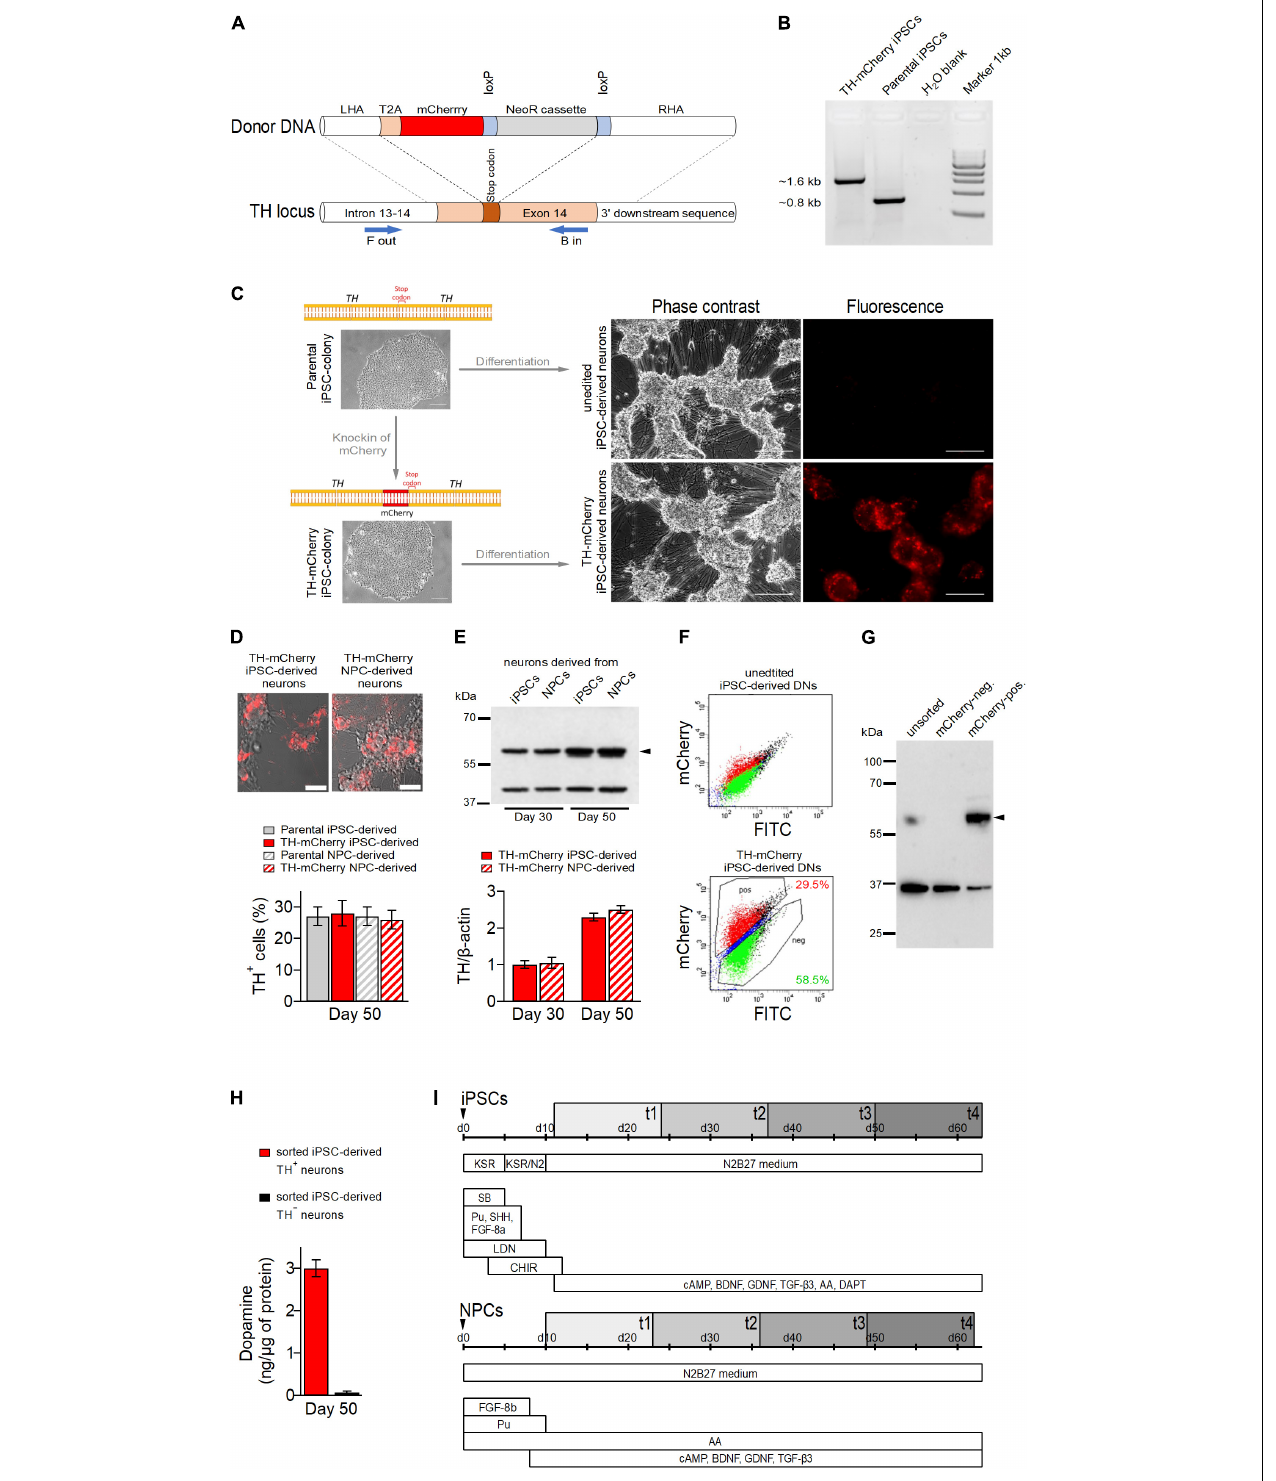
FIGURE 1 | Generation of TH-mCherry reporter iPSC and NPC lines and associated dopaminergic neuronal cultures. (A) Scheme illustrating the recombination strategy employed for genome editing. Blue arrows represent primers used for the PCR screening procedure. (B) PCR analysis of edited (TH-mCherry iPSCs) and unedited (Parental iPSCs) iPSC lines confirming correct integration of the T2A-mCherry sequence in the TH locus of the parental iPSC line. (C) Phase contrast and associated fluorescence images of representative clusters of undifferentiated iPSC colonies ( left ) and terminally differentiated DN cultures ( right ), obtained